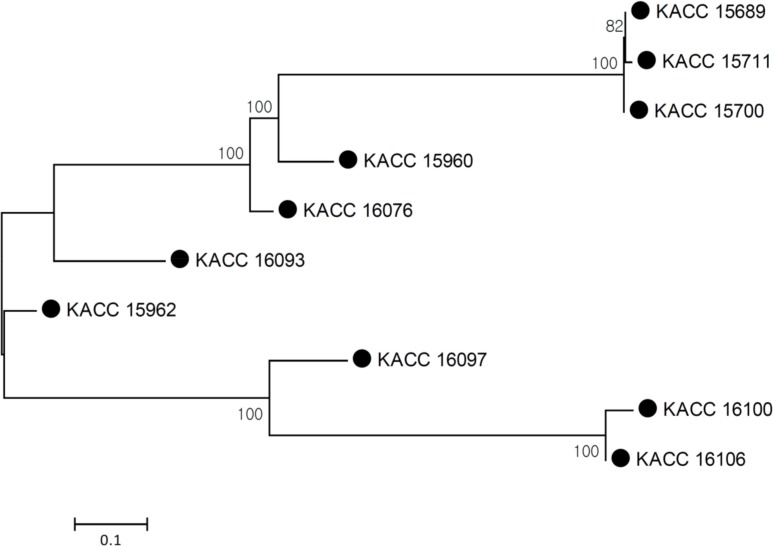
Evolutionary relationships of 10 soybean strains based on 8,850 SNPs from 990 core genes.The optimal tree with the sum of branch length = 2.15 is shown. The percentage of replicate trees in which the associated taxa clustered together in the bootstrap test (1000 replicates) are shown next to the branches. The tree is drawn to scale, with branch lengths in the same units as those of the evolutionary distances used to infer the phylogenetic tree. The evolutionary distances are in the units of the number of base substitutions per site.